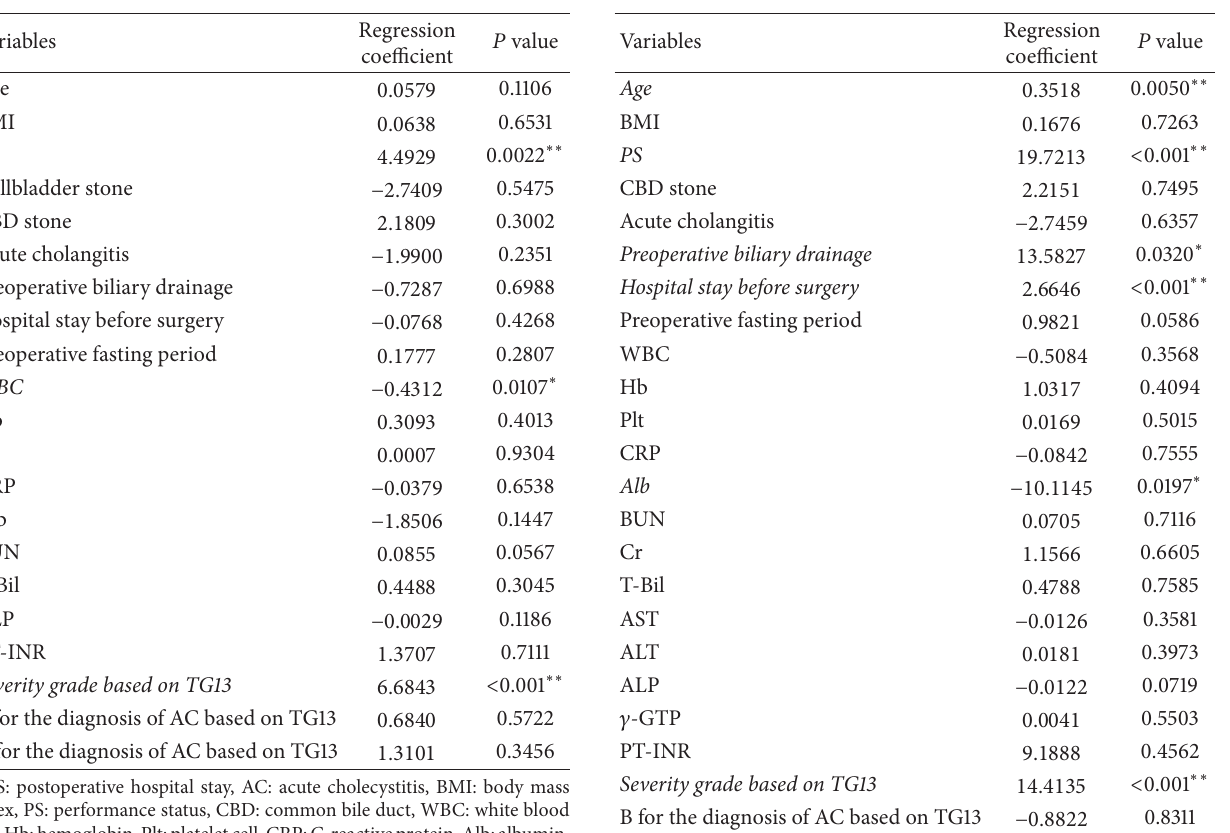
Table 5: Multivariate analyses of the factors influencing PHS in the 171 patients who had definite, suspected, or unmatched AC diagnoses.